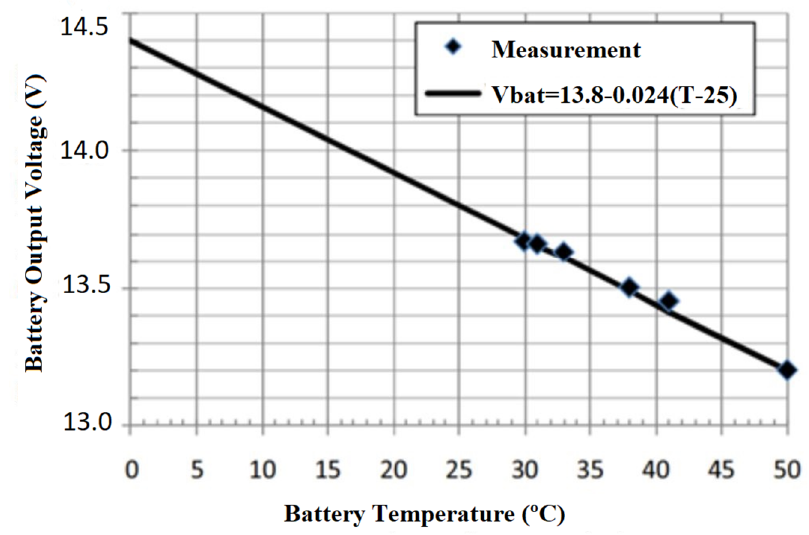
Figure 8. Relationship between temperature and battery output voltage: the output voltage reduces linearly with increasing battery temperature [69] .